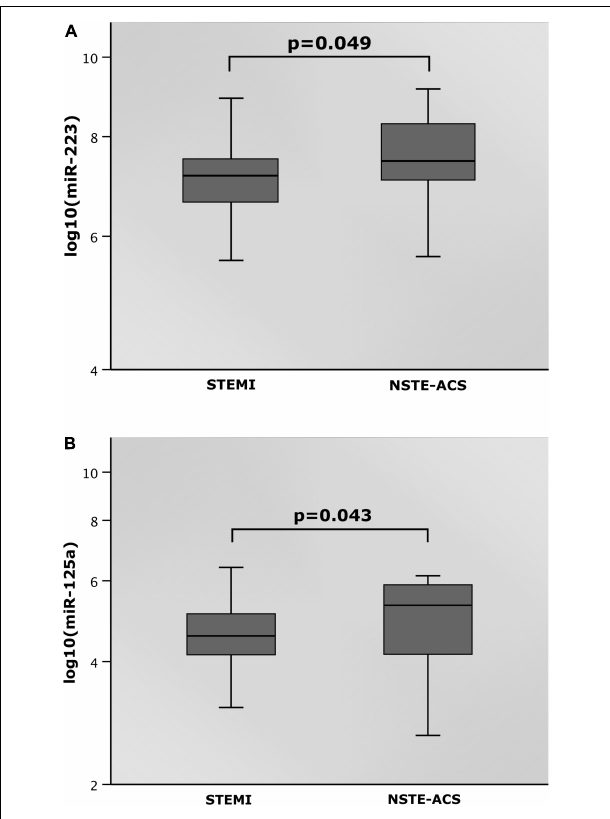
FIGURE 2 | (A) MicroRNA (miR)-223 and (B) miR-125a in regard to status at hospitalization.